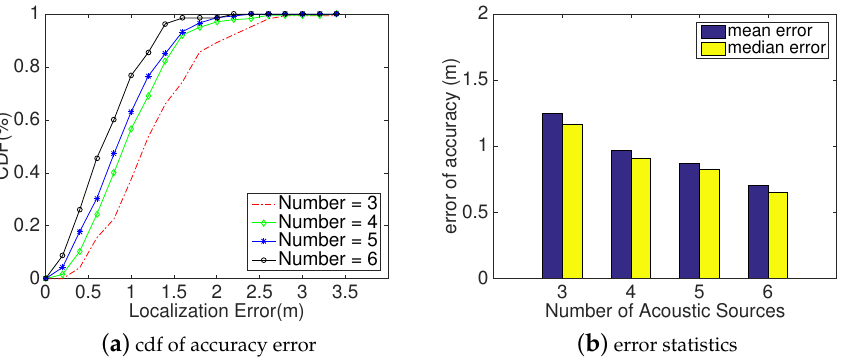
Figure 12. SITE ’s Device Localization Accuracy measured against the number of acoustic sources. (a) plot cdfs of accuracy error at different numbers. (b) Two statistical measurements of performance: mean error and median